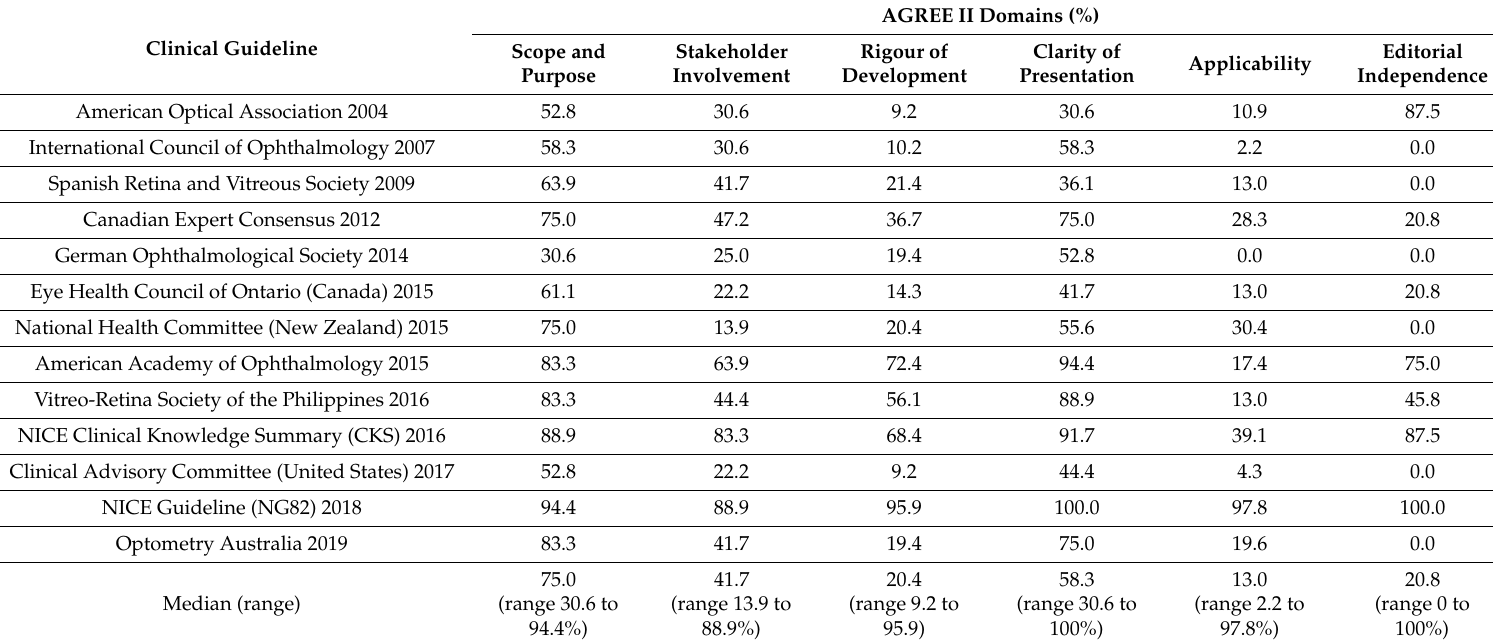
Table 5. Quality, measured in %, of the included AMD clinical guidelines, based on the six assessment domains of the Appraisal of Guidelines for Research and Evaluation II (AGREE II) appraisal tool. The scores for each of the six domains were calculated by summing up all the scores of the individual items for that domain, and then scaling the total as a percentage of the maximum possible score for each